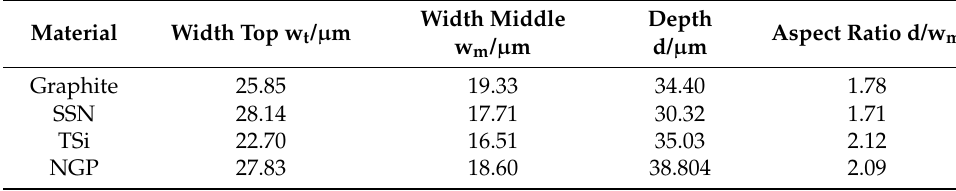
Table A1. Measurements of the structures that were generated by a laser beam.